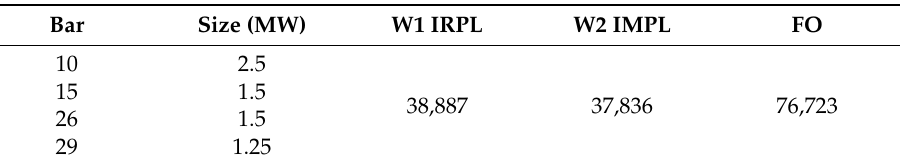
Table 6. Best result using Genetic Algorithms (GA).